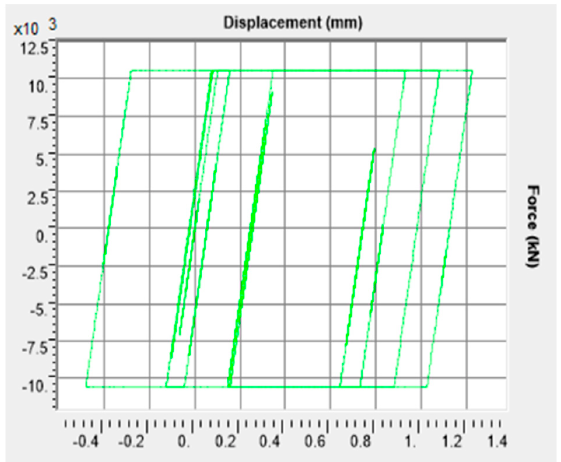
Figure 9. Hysteresis curve for whole building with slab model at 11th storey for KHC model in the ULS case.